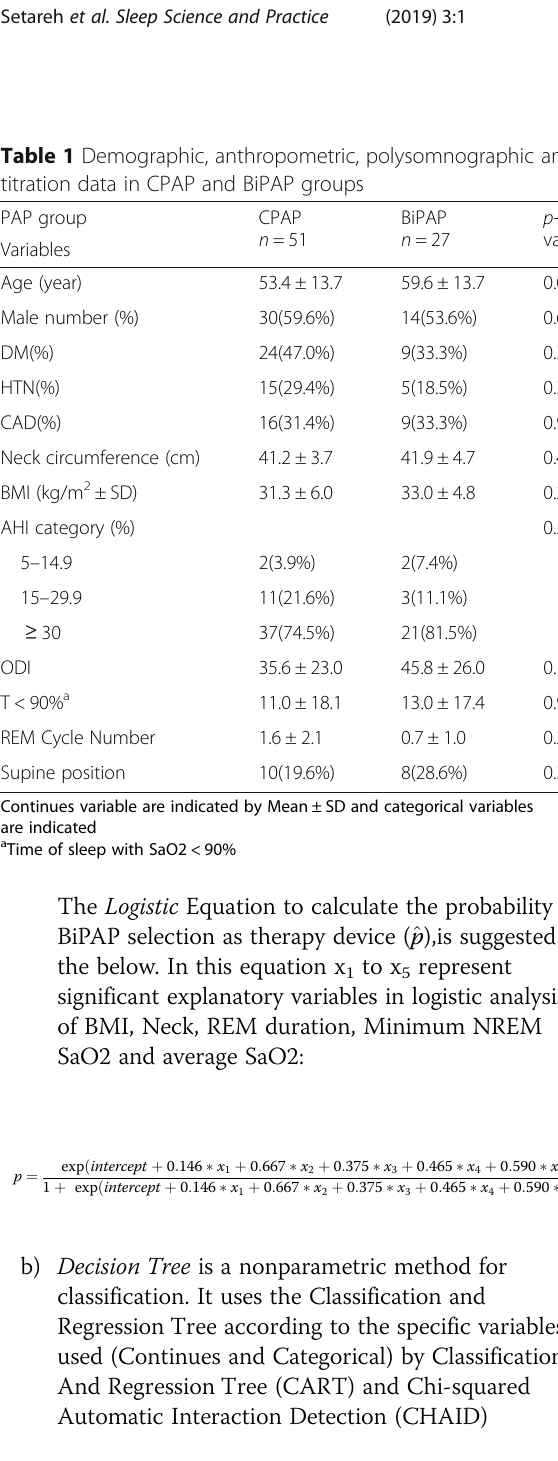
Table 2 SaO 2 levels and duration of apnea maneuver in CPAP and BiPAP groups PAP group CPAP BiPAP